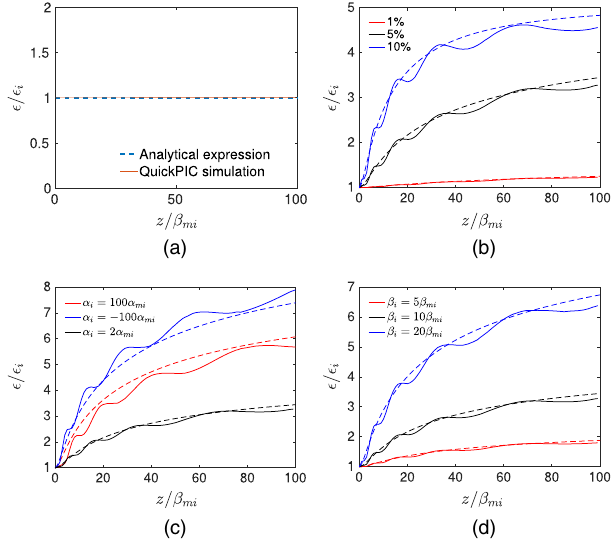
n p 0 FIG. 2. Emittance evolution in plasma ramp: n p ð z Þ ¼ ð 1 þ z=l Þ 2 ( l ¼ 5 , l and z are normalized to β mi ). For (a) the beam is initially − 0 . 1 , and the beam has a matched: β i ¼ β mi ; α i ¼ α mi ¼ − 1 2 l ¼ 5% energy spread. For (b) the beam is initially unmatched: β 10 β ; α 2 α i ¼ mi i ¼ mi , and the beam has 1%, 5%, 10% initial energy spreads respectively. For (c) the beam is initially un- matched: β i ¼ 10 β mi ; α i ¼ 2 α mi ; 100 α mi ; − 100 α mi respectively, and the beam has a 5% energy spread. For (d) the beam is initially unmatched: α i ¼ 2 α mi ; β i ¼ 5 β mi ; 10 β mi ; 20 β mi respectively, and the beam has a 5% energy spread. In (b)(c)(d), the solid lines are from QuickPIC simulations, and the dashed lines are from the analytical expression (13). In these three plots, the solid black lines correspond to the same simulation result, and the dashed black lines correspond to the same analytical